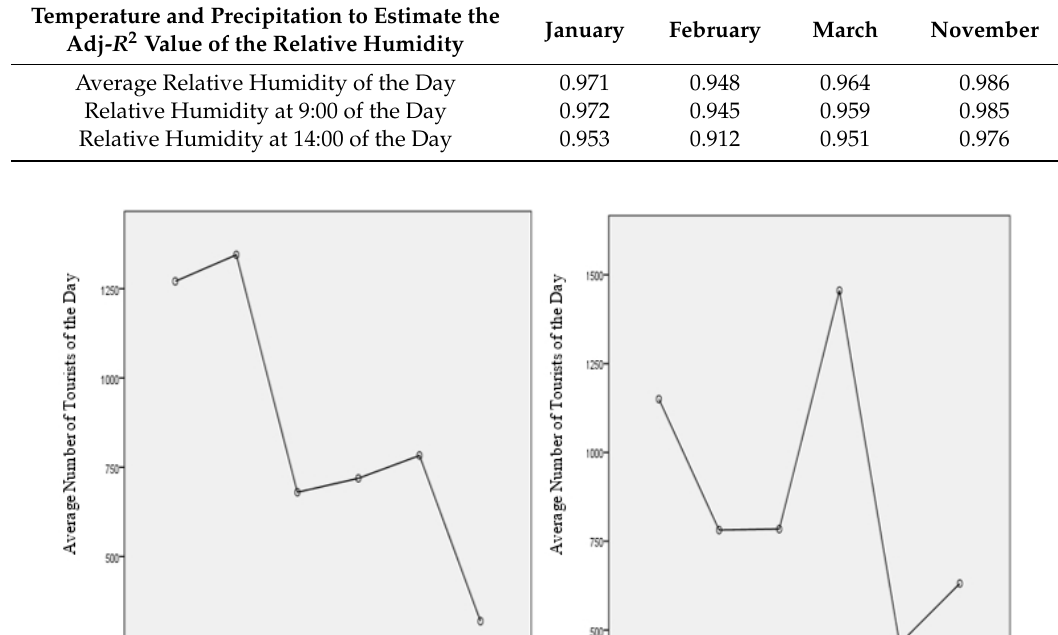
Table 2. Temperature and precipitation to estimate the adj- R 2 value of the regression equation. Temperature and Precipitation to Estimate the